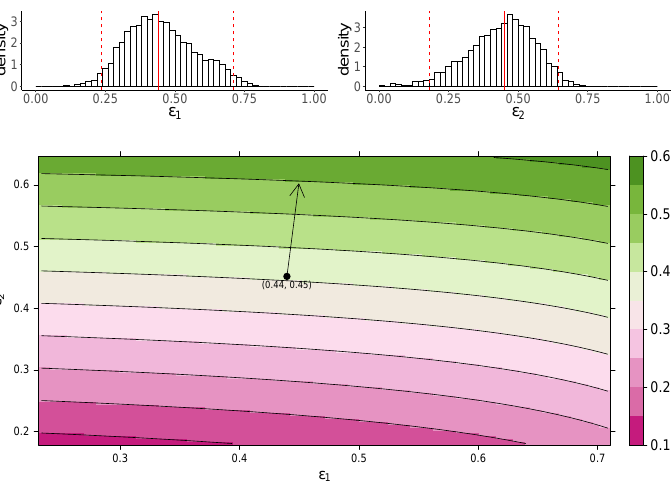
Figure 3. The dependence of the AUC M on the effects of MUC1 for the TIV model. The upper panel shows the marginal posterior distribution of ε 1 ( left ) and ε 2 (right ). The 95% credible interval (CI) for the parameters is indicated between the two red-dashed lines, and the red-solid line indicates parameters’ median value. The heatmap shows dependence of macrophage reduction efficiency on ε 1 and ε 2 . The black circle indicates the pair of median values of ε 1 and ε 2 , and the arrow indicates the direction of the rate of change in macrophage reduction efficiency at that